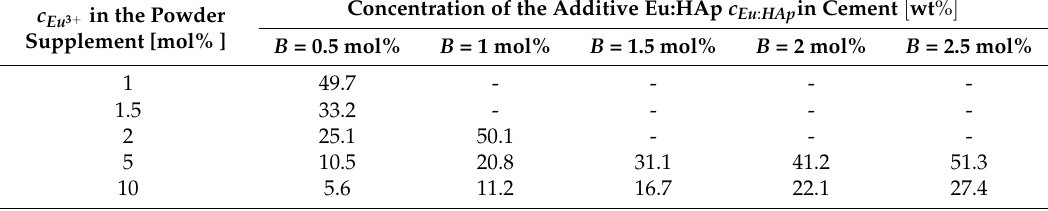
Table 1. Composition of Eu-doped calcium phosphate cements (Eu:CPC) for different bulk concentrations B . Concentration of the additive Eu 3+ -doped hydroxyapatite (Eu:HAp) is listed. Concentration of the Additive Eu:HAp c Eu : HAp in Cement [ wt % ] c Eu 3 + in the Powder Supplement [mol% ] B = 0.5 mol% B = 1 mol% B = 1.5 mol% B = 2 mol% B = 2.5 mol% 49.7 -